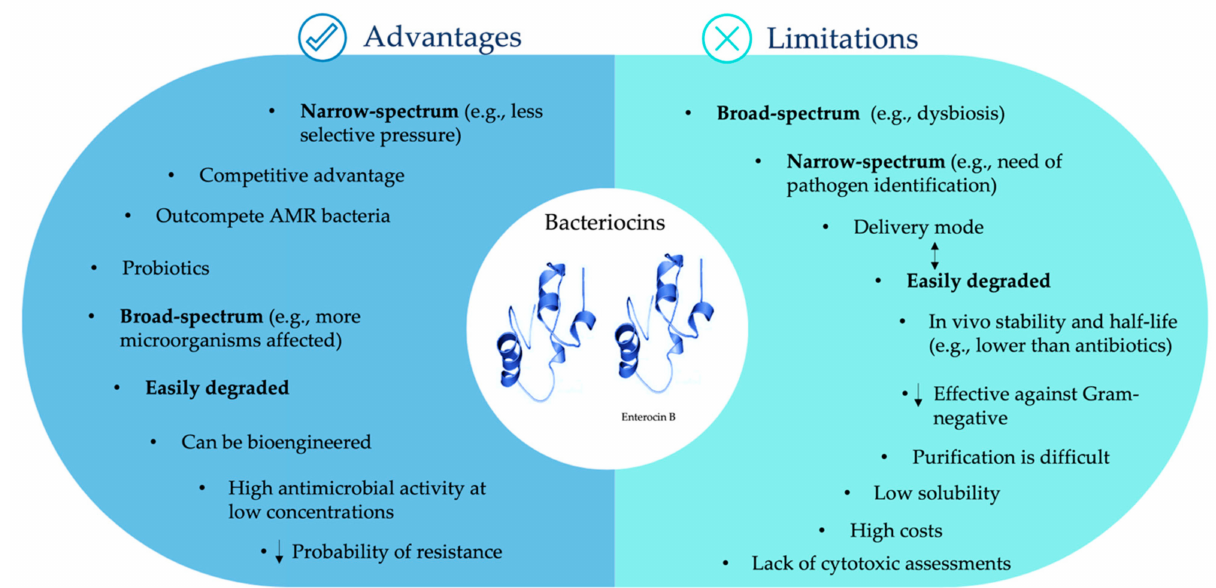
Figure 2. Advantages and limitations of bacteriocins. Words in bold indicate that such a bacteriocin feature can be an advantage or a limitation, according to different contexts. Arrows pointing down mean “less”. Arrows pointing simultaneously up and down mean “are